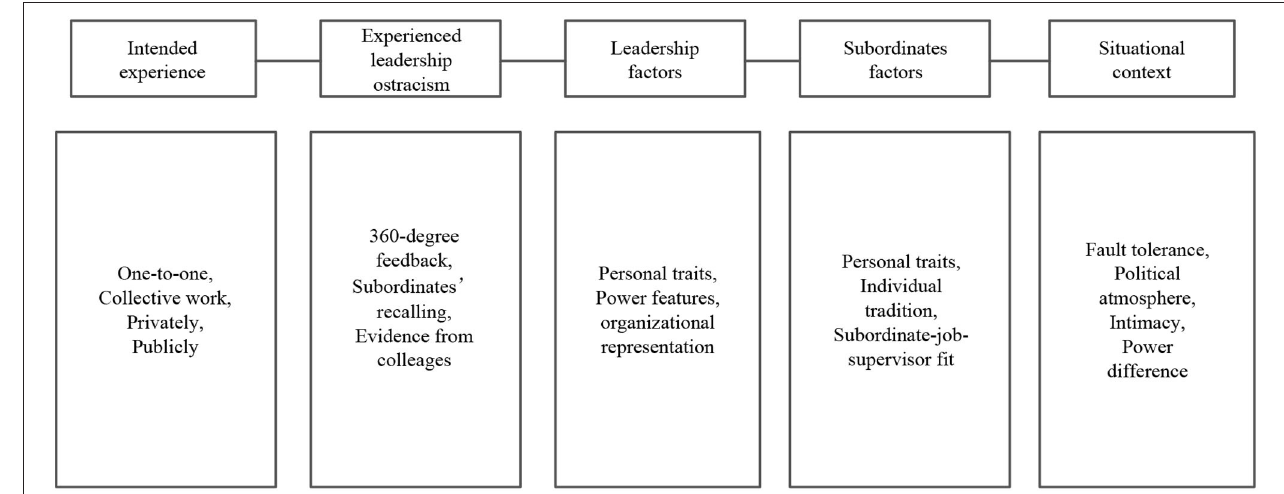
FIGURE 2 | Guiding investigation